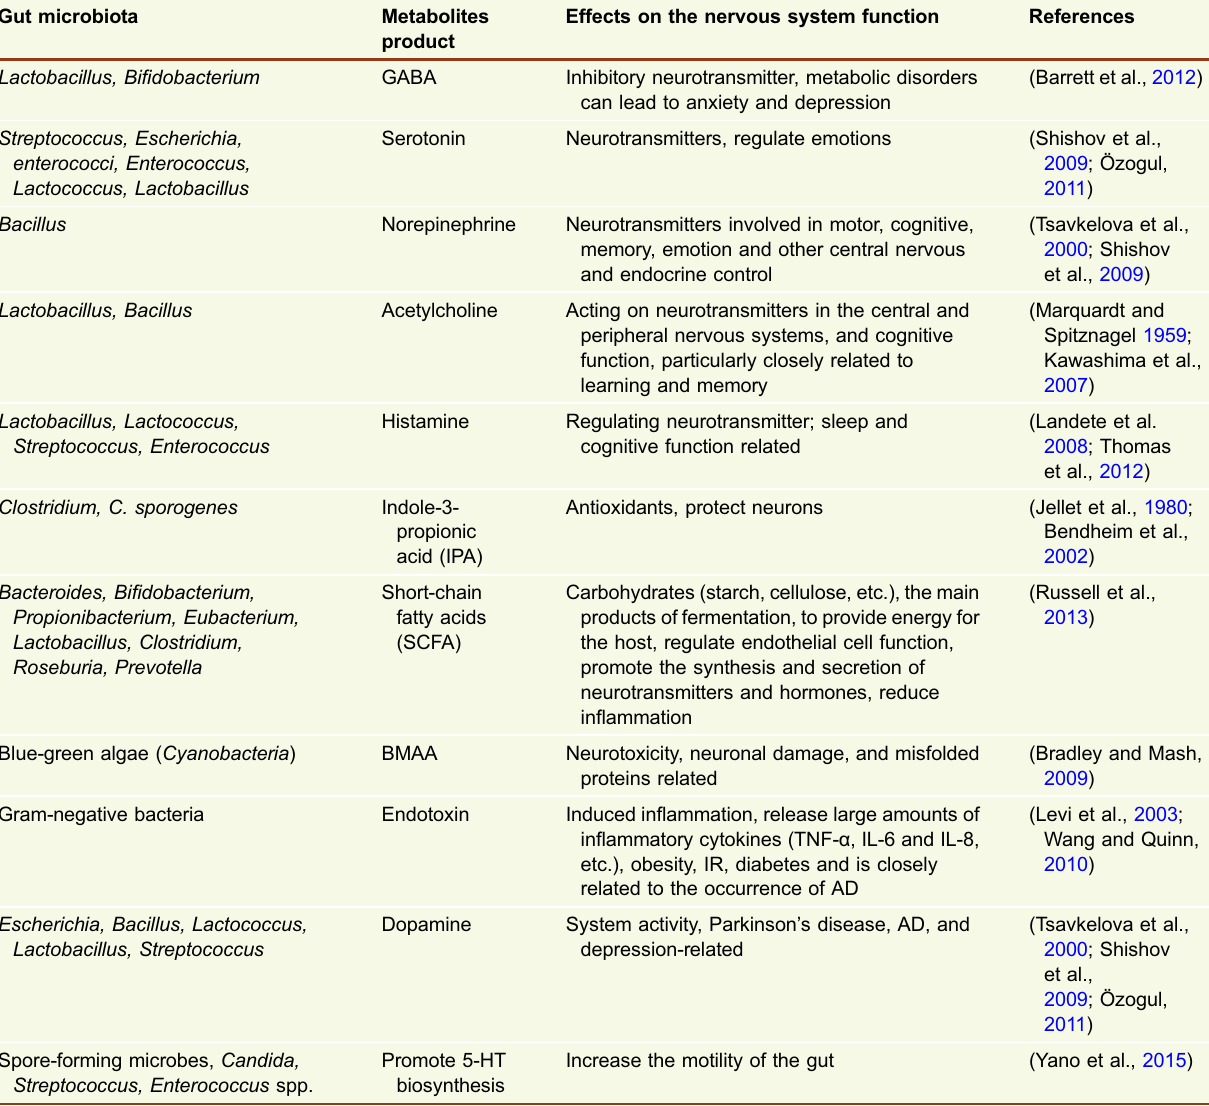
Table 1. The gut bacteria and their metabolites on the nervous system Gut